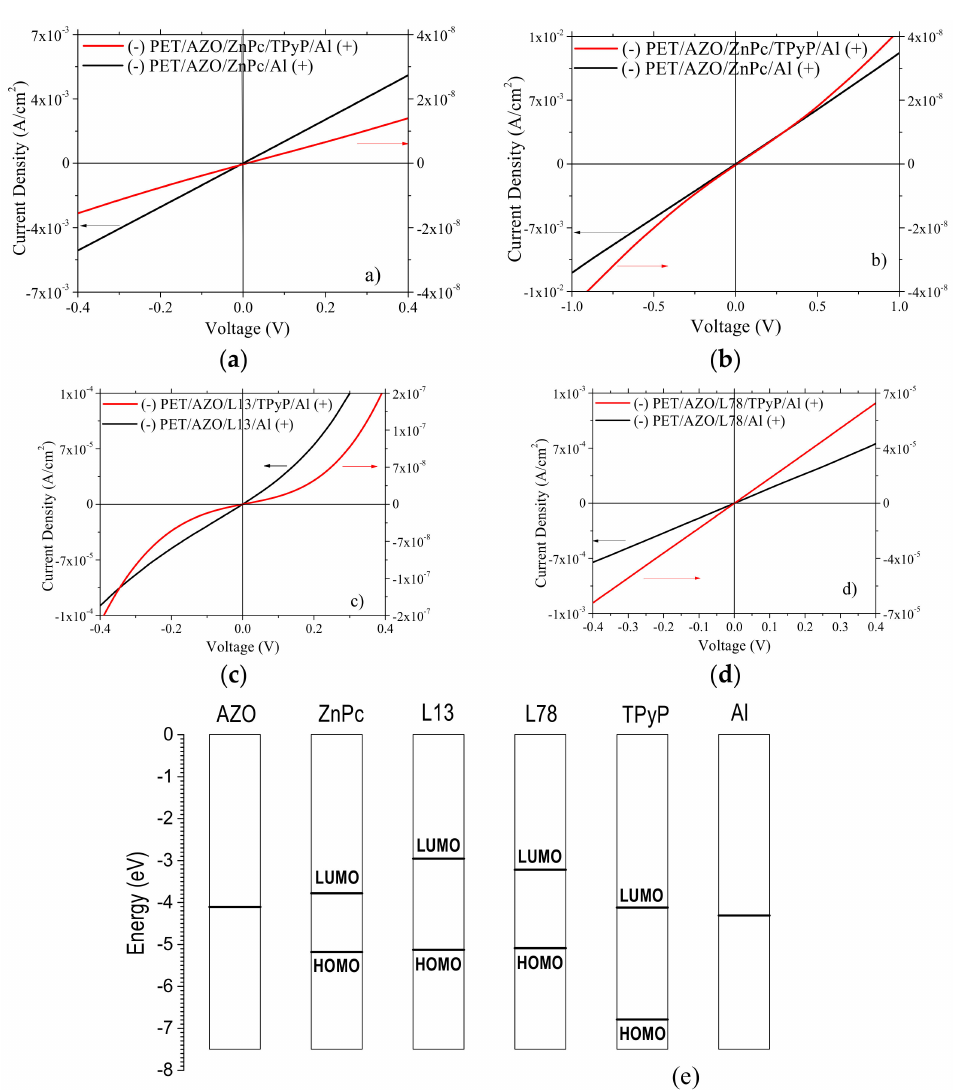
Figure 9. Typical J-V characteristics at room temperature in dark for organic heterostructures with single- and bi-layer organics on PET substrate and AZO and Al electrodes ( a – d ). The polarization of the heterostructures is indicated in the figure. The substrates are indicated in Table 1. Energy levels diagram for each component of the investigated organic heterostructures ( e